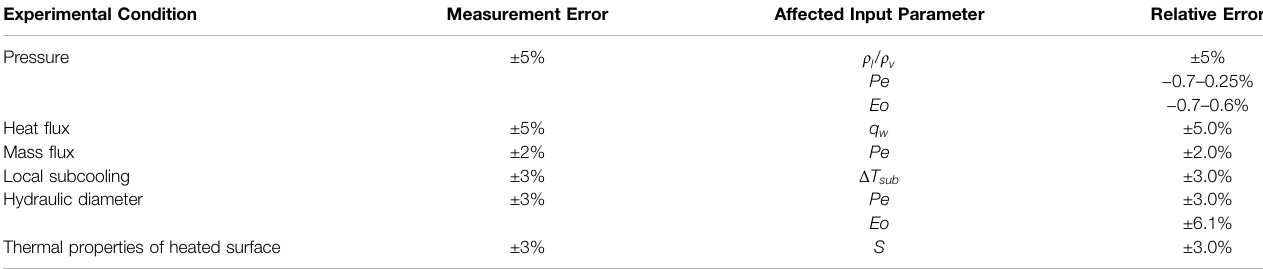
TABLE 4 | The potential measuring error for different experimental conditions.